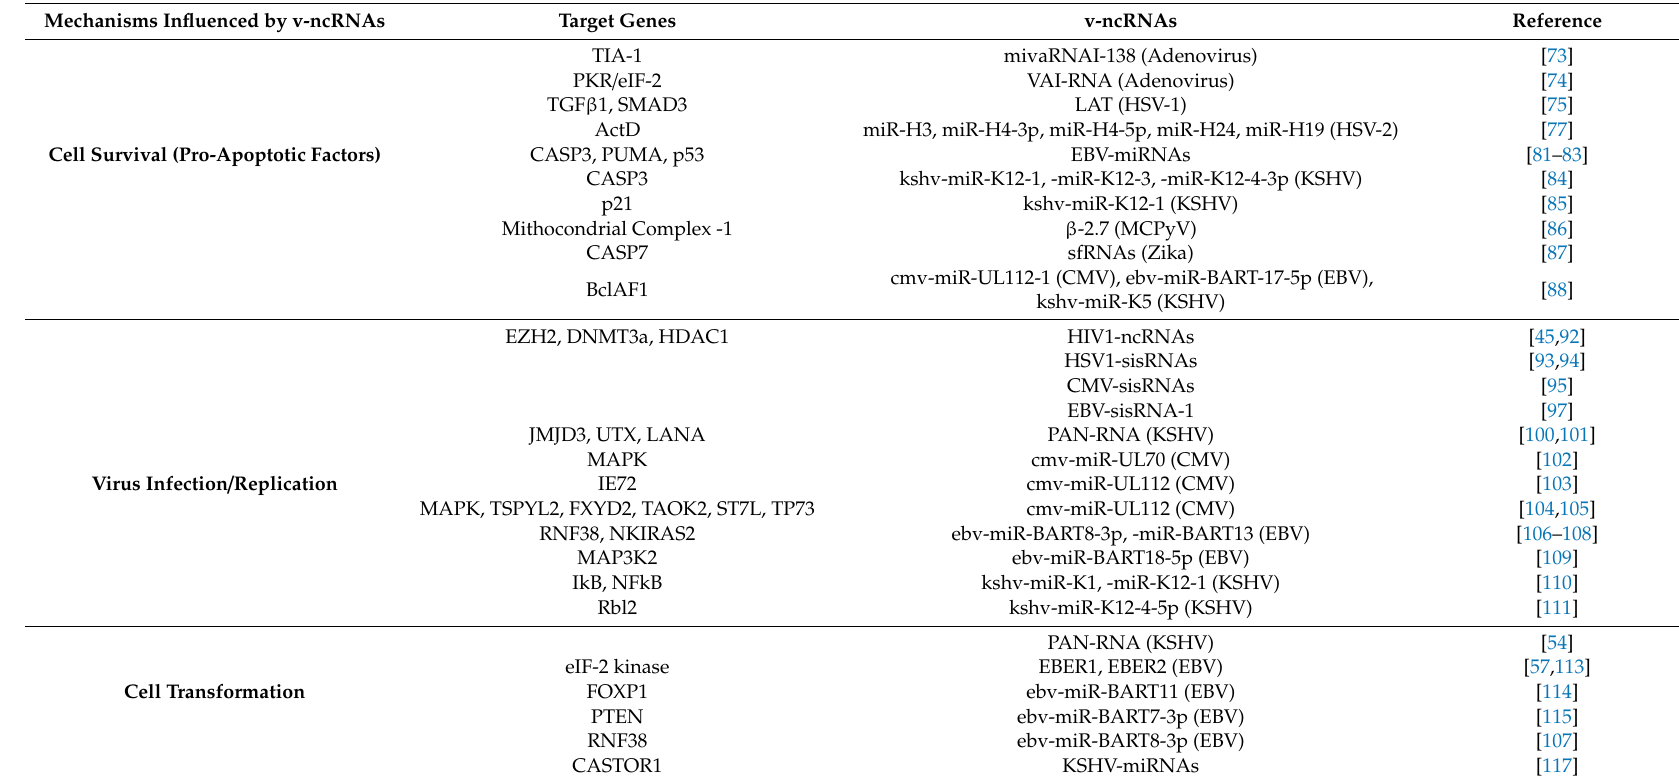
Table 2. Pathogenetic mechanisms influenced by